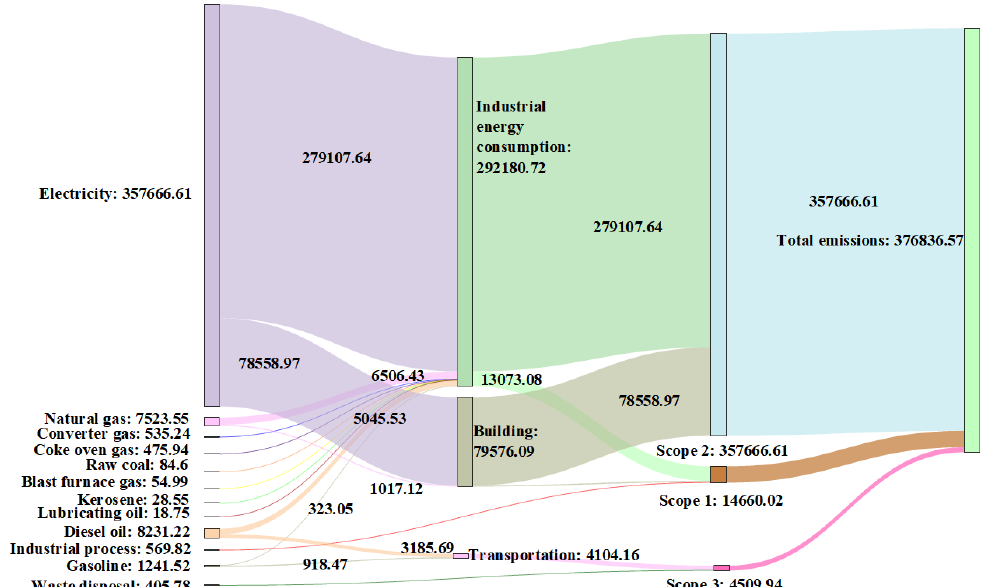
Figure 6. The Maanshan Economic and Technological Development Area (MDA) CO 2 flow chart of 2016. Measurements are indicated in tons.